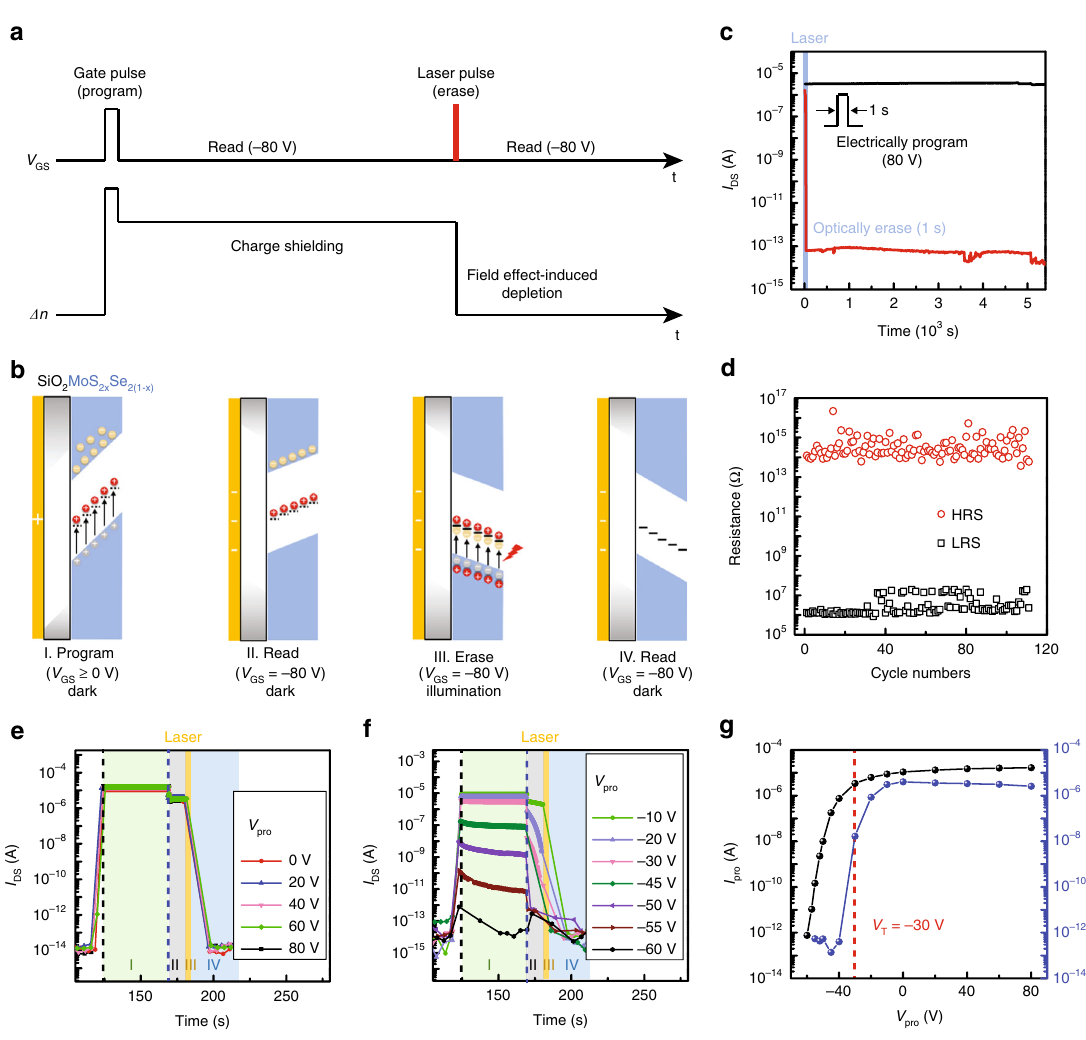
Fig. 4 Gate voltage-dependent memory effect and performance evaluation. a Upper panel, schematic illustration of the program, readout and erase process of a single operation cycle. Lower panel, the corresponding time evolution of electron concentration ( Δ n ) in device channel. b Schematic band diagrams of the corresponding program (I), readout (II, IV), and erase (III) states. Electrons and holes are represented by yellow and red balls. Gray balls are the disappeared electrons or holes. Black dashed and solid lines in the bandgap denote the empty state (with trapped holes) and occupied state (without trapped holes). c Retention performance of two memory states after electrically programming and optically erasing. d Endurance characteristics of the memory for over 100 program/erase cycles. Laser wavelength and power density are 1550 nm and 100.6 μ W cm − 2 , respectively. e , f Time evolution of current in a single operation cycle with various programming voltages ( V pro ). V DS = 1 V, T = 80 K. Region I, II, III, and IV denote the states of programming, readout (under program state), erasing, and readout (under erase state) shown in ( b ), respectively. g The plot of programming and read current ( I pro and I V V read , the current values along the black and blue dashed line in e , f ) versus pro . Threshold voltage ( T ) is a critical gate voltage for storing charges. Source data are provided as a Source Data fi